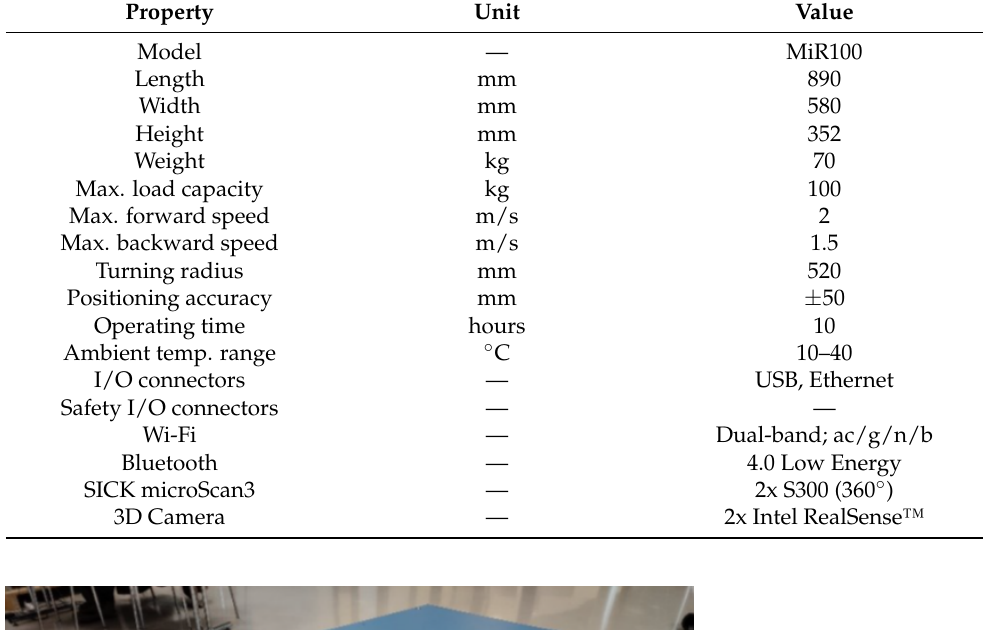
Table 1. Specifications of the MiR100 mobile robot [20].